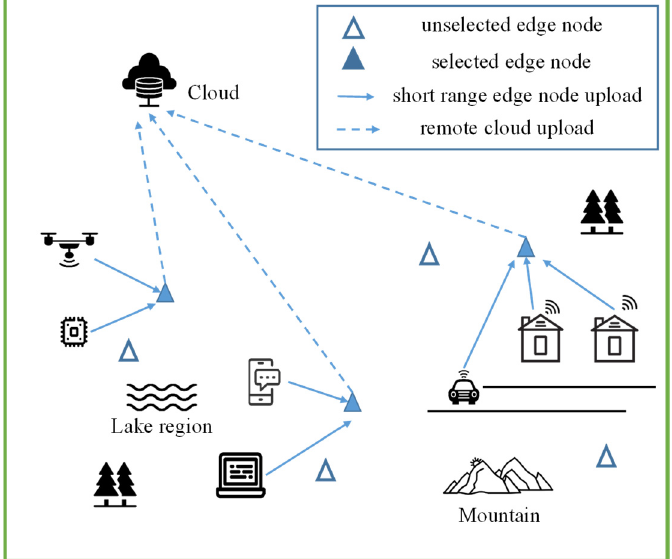
Figure 1. The architecture of multiple terminals, edge nodes, and clouds.